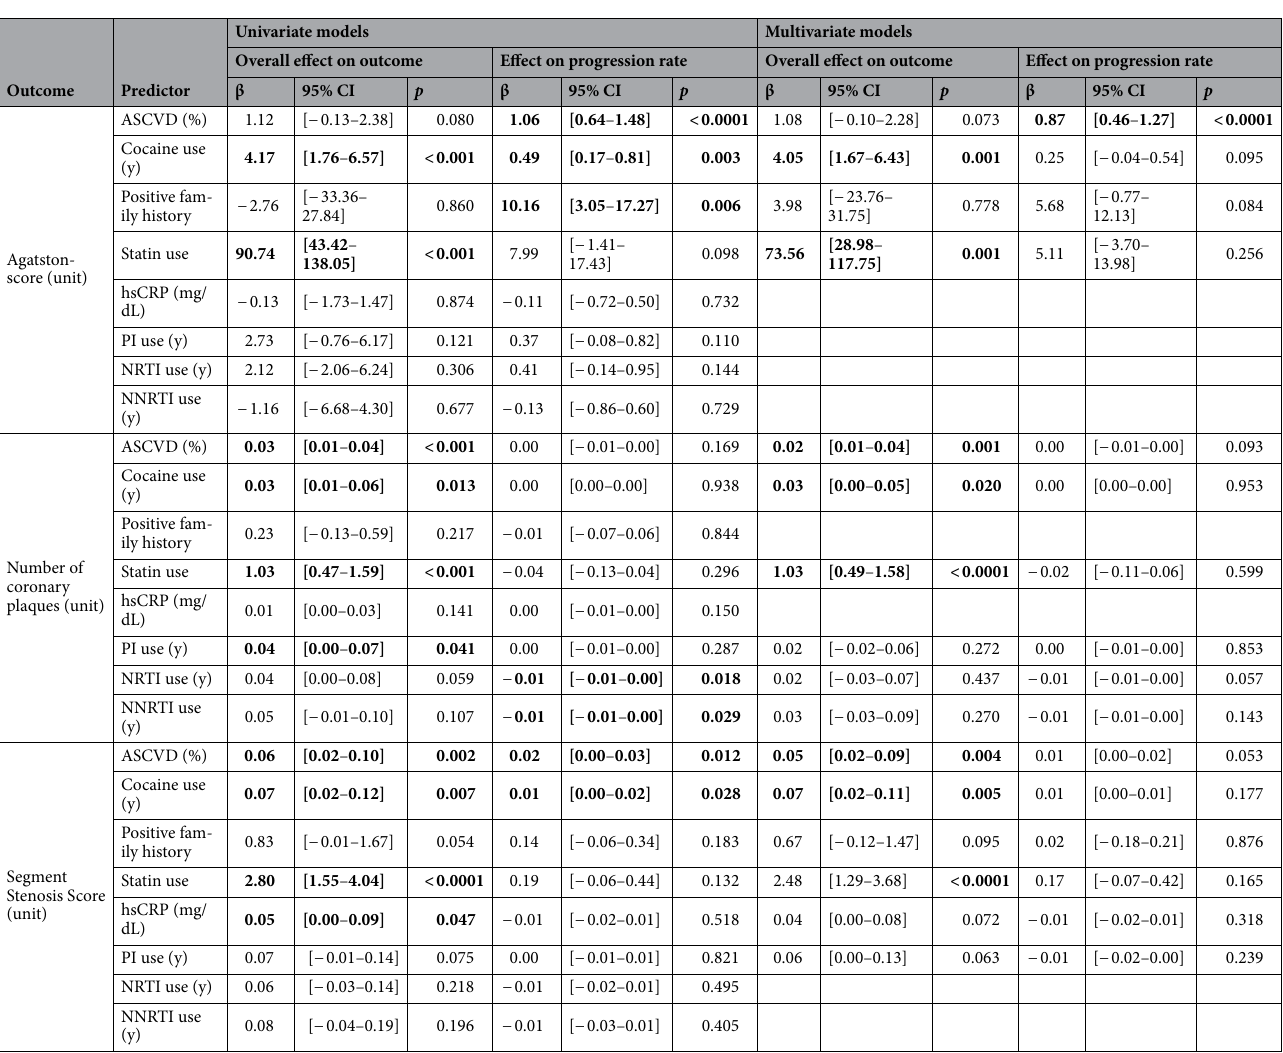
Table 3. Predictors of coronary artery disease outcomes among people living with HIV. Abbreviations: β unstandardized beta coefficients from linear mixed model; ASCVD risk cardiovascular risk defined